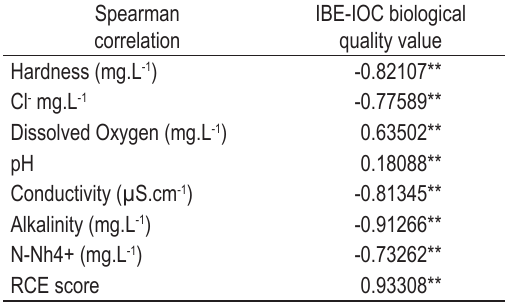
Table 3. Results of the of the Spearman Correlation Analysis comparing the IBE-IOC biological quality values with values of physical and chemical parameters and of RCE for each site of the Serra do Mar Mountains, State of Rio de Janeiro, Brazil, sampled in June 2004, November 2004 and March 2005, in